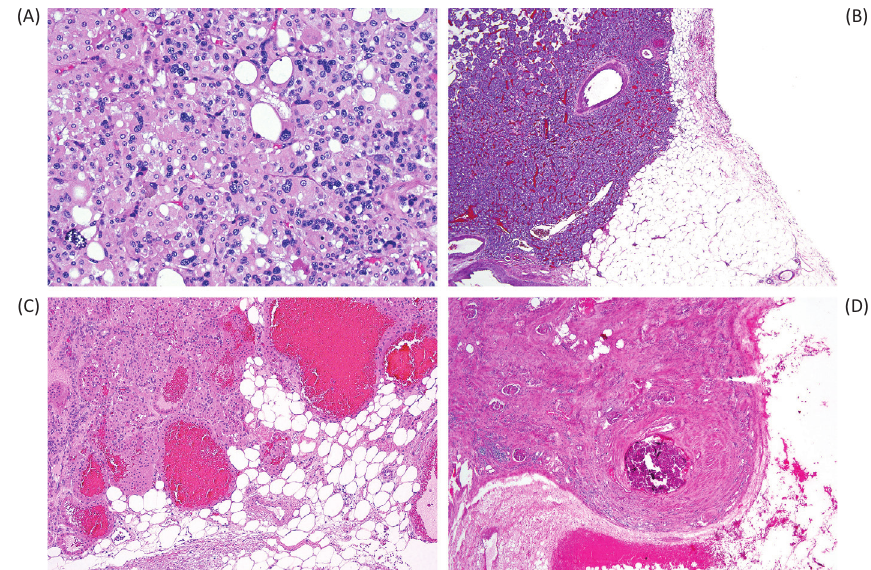
Figure 2. Pseudomalignant features in oncocytoma can include degenerative-type atypia (A), intermingling of the tumor with fat (B–C), and vascular invasion or large vein invasion (D). Despite that these would confer a high stage to renal cell carcinoma, they are currently thought to have no impact on the benign behavior of